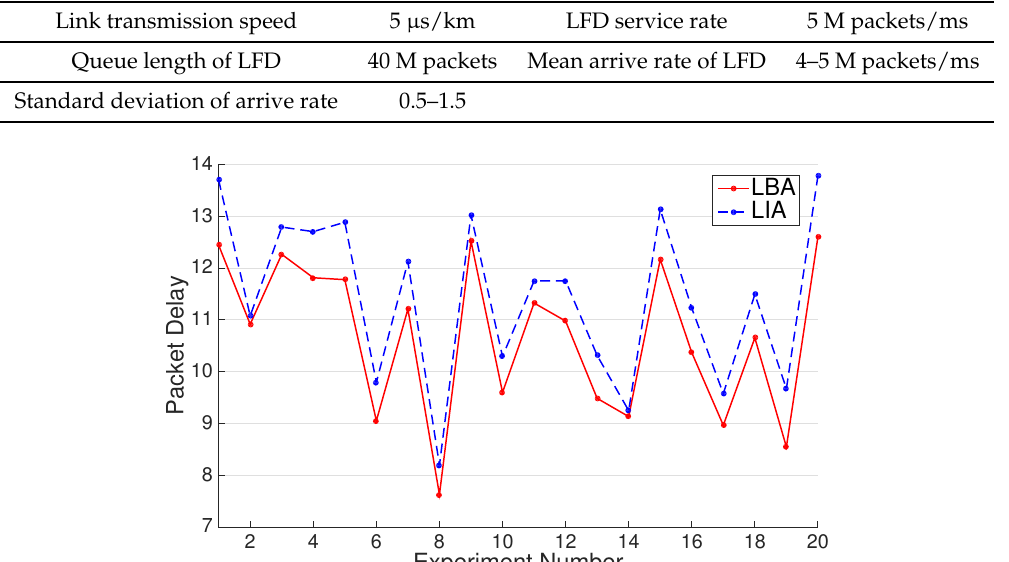
Figure 4. Average SFD-to-controller latency with different traffic. SFD: SDN-enabled Forwarding Device. LBA: Legacy Based Assignment. LIA: Legacy Ignored Assignment.